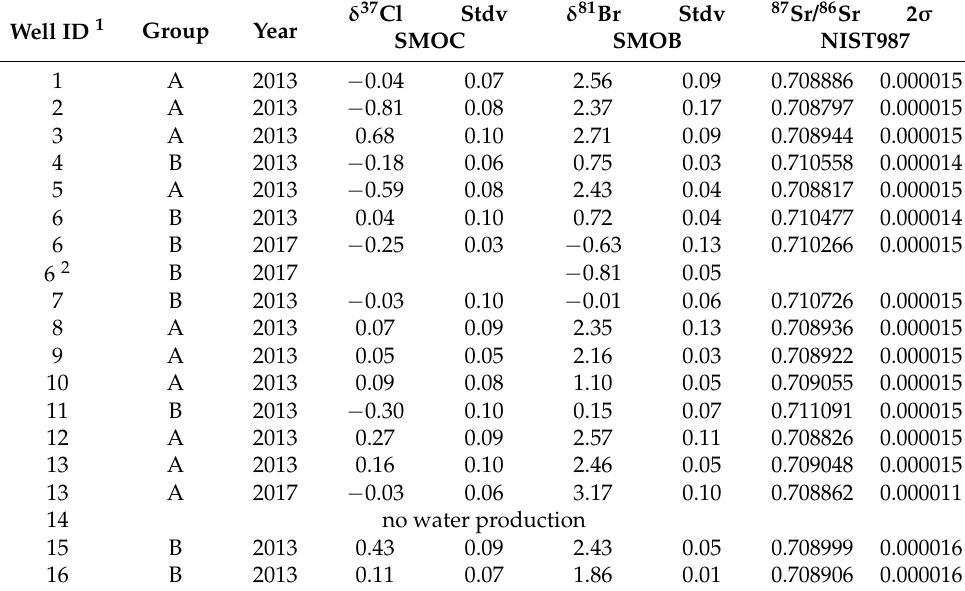
Table 1. Stable chlorine, bromine, and 87 Sr/ 86 Sr isotopic results for water samples and one gas sample collected from Cherokee Basin coal-bed methane production wells.